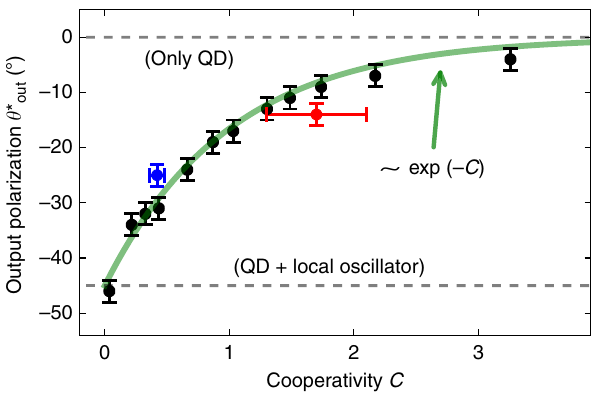
Figure 4 | Special polarization and cooperativity. Black: numerically determined special polarization angle, where photon bunching in transmission is maximized, as a function of the cooperativity C , which in Figure 3 | Photon bunching and purification. Experimental ( a ) and turn is modified by varying only the QD lifetime g || . The green curve is given theoretical ( b ) data of the second-order correlation function as a function of by the phenomenological expression (cid:5) 45 (cid:2) exp ( (cid:5) C ): in the limit of high C , the QD frequency and output polarization ( y out ), taken in the area marked the QD alone can efficiently filter out single-photon states, leading to with a white rectangle in Fig. 2. The vertical dashed lines indicate the special photon bunching. However, for low cooperativity C , it is advantageous to polarization angle and the QD axis, and the horizontal line indicate the QD mix the quantum-dot scattered light with a ‘local oscillator’ provided by resonance orthogonal polarization. The error bars (all s.d.) are due to numerical errors in optimizating the laser frequency. The red data point corresponds to the sample presented here; the blue data corresponds to another device with electromagnetic field transmitted through the cavity in two lower cooperativity. orthogonally polarized components: the signal Field E S polarized ¼ 0 (cid:2) and the local along the QD resonance polarization y X QD oscillator E LO , which has interacted with an empty cavity, because . Now, we consider three it is polarized orthogonally to y X QD cases: (i) efficient interaction of the QD with incident light (cooperativity C 4 1), (ii) intermediate interaction ( C E 1) and (iii) weak interaction ( C - 0). The special polarization angles for various cooperativities are shown in Fig. 4.